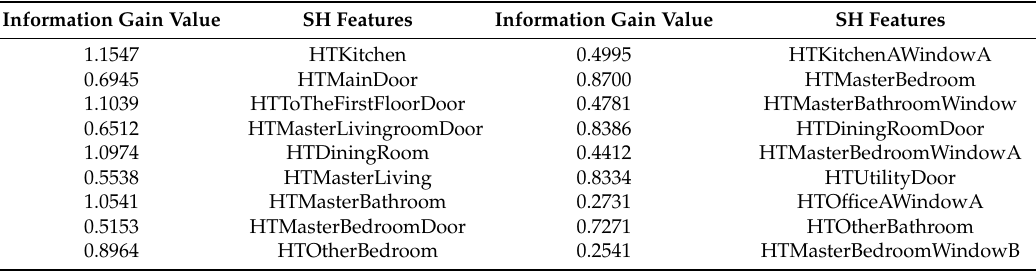
Table 16. InfoGain method predictions for indoor formaldehyde in IAQ 1 .